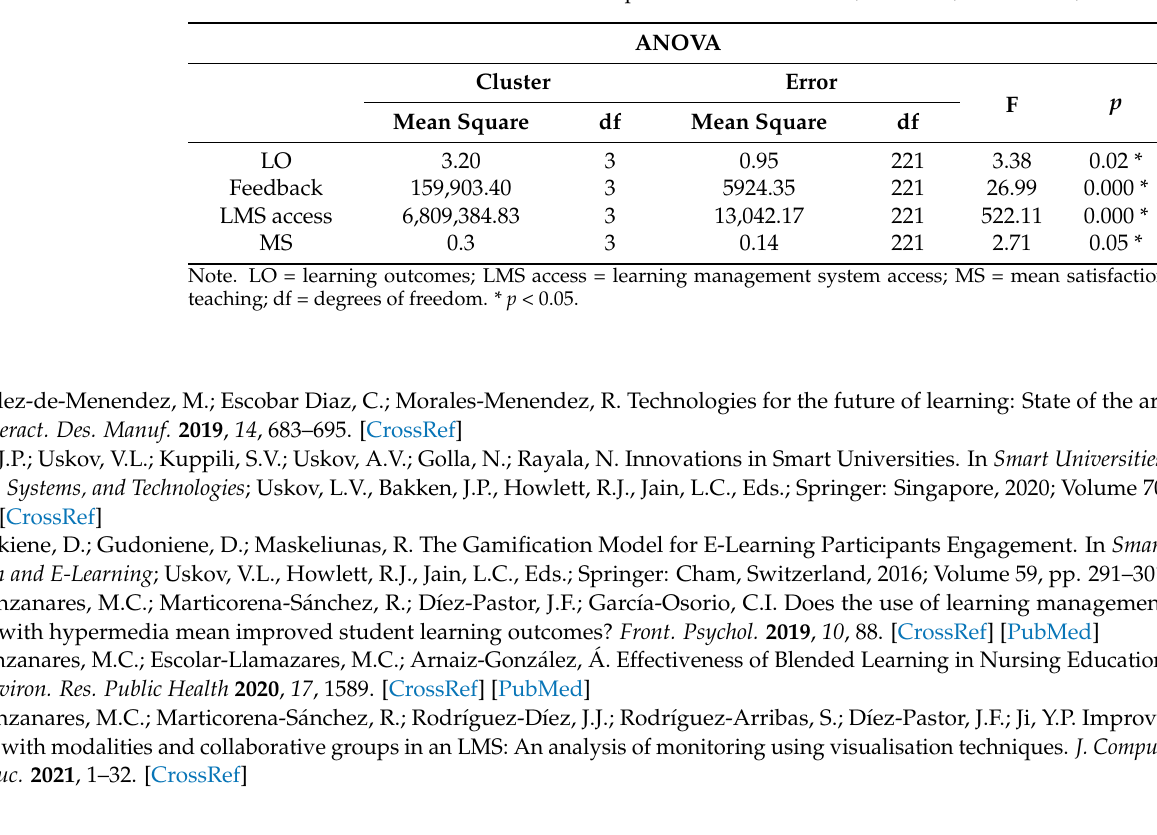
Table A3. ANOVA between clusters with respect to the variables LO, feedback, LMS access, and